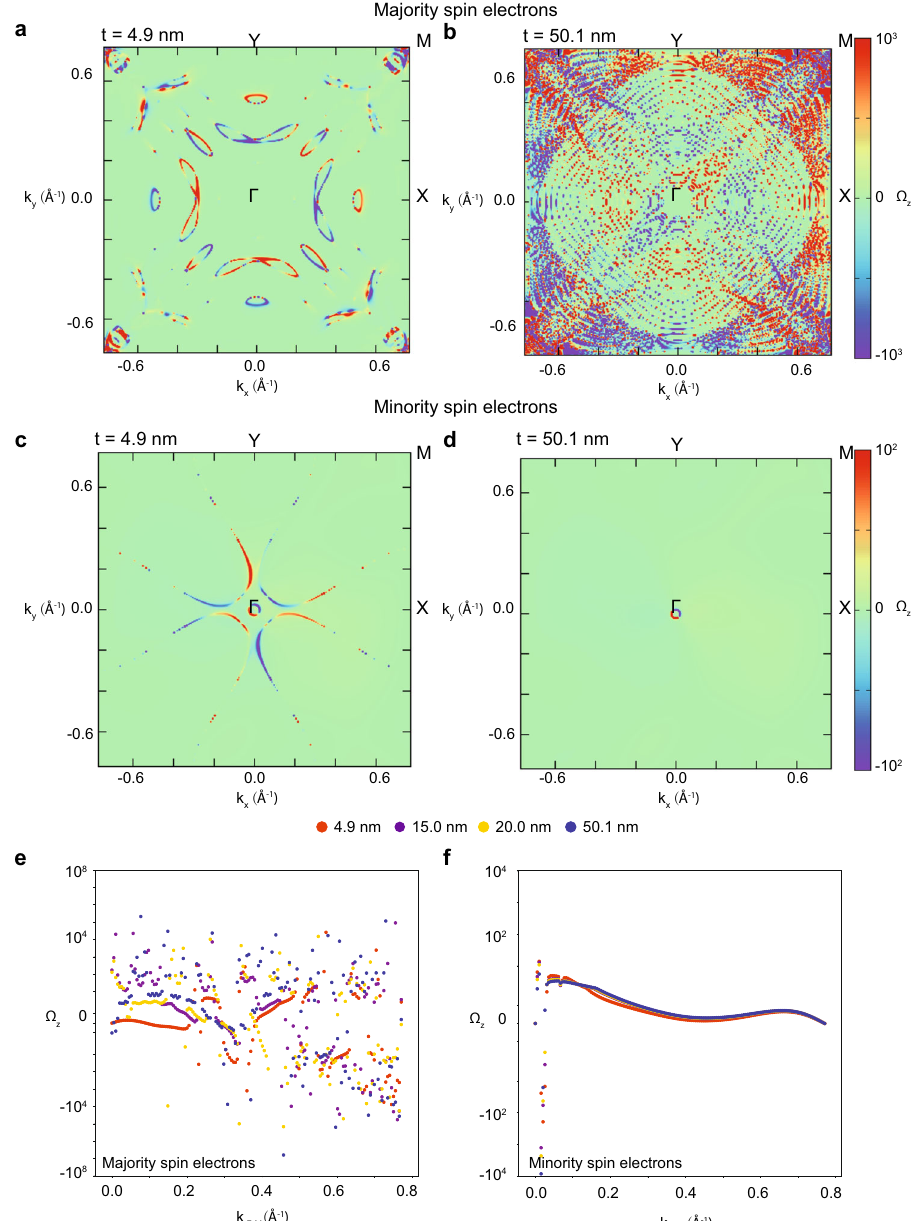
Fig. 4 Evolution of Berry curvature in Co 2 MnGa thin fi lms. a – d show the calculated averaged-integral of z-component Berry curvature ( Ω z ) of occupied bands from minority and majority spin electrons for Co 2 MnGa thin fi lms of 4.9 nm and 50.1 nm, e, f show a comparison of Ω z along Γ -M line for Co 2 MnGa thin fi lms of 4.9, 15.0, 20.0, and 50.1